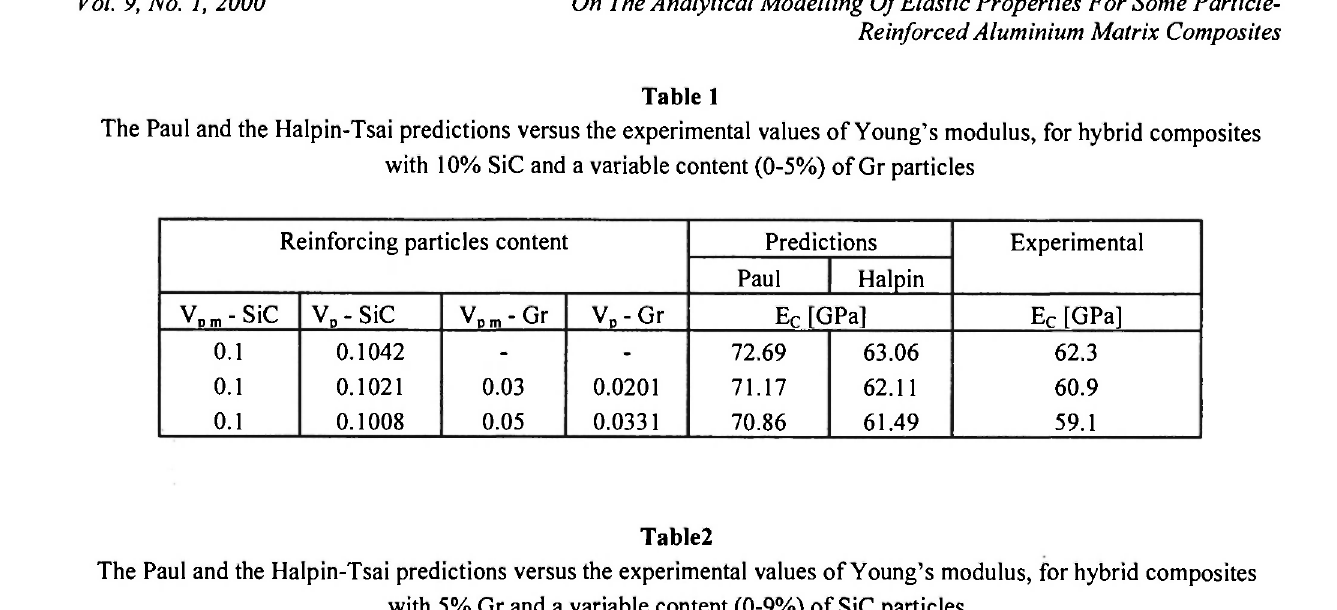
The Paul and the Halpin-Tsai predictions versus the experimental values of Young's modulus, for hybrid composites with 10% SiC and a variable content (0-5%) of Gr particles